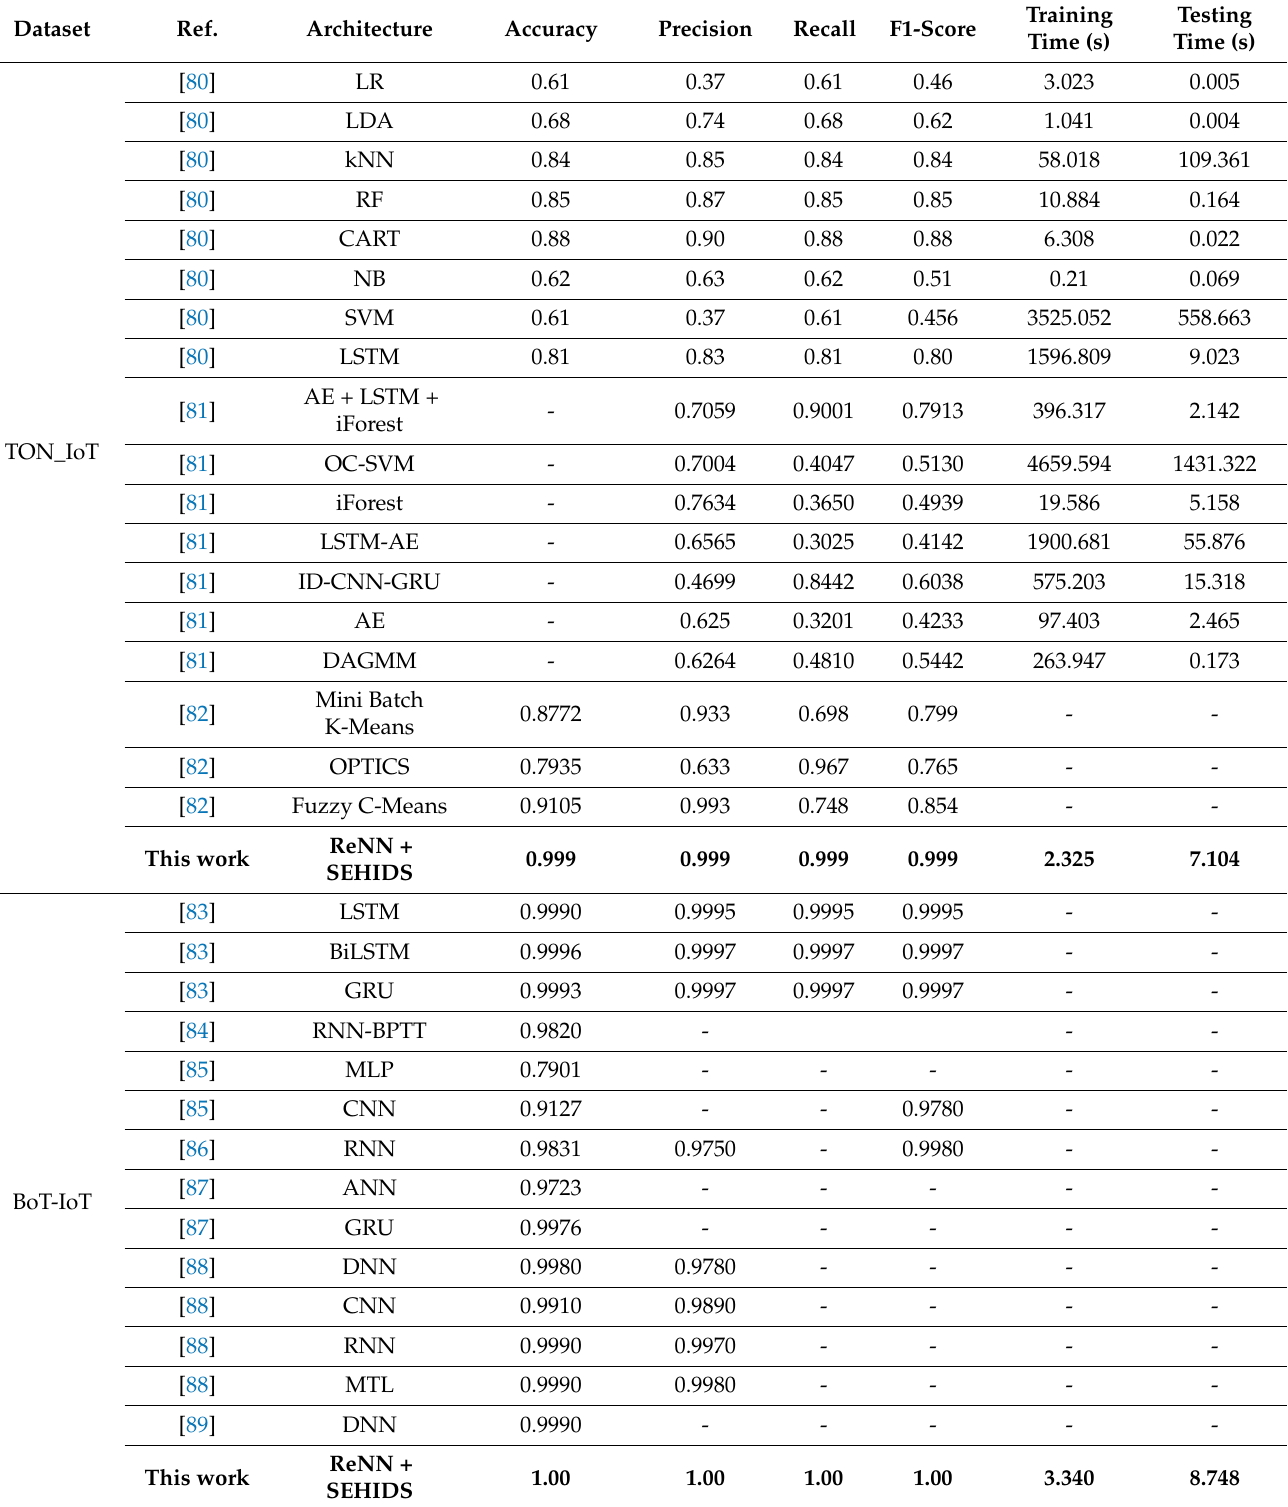
Table 2. Comparison between the performance metrics of SEHIDS based models and some related